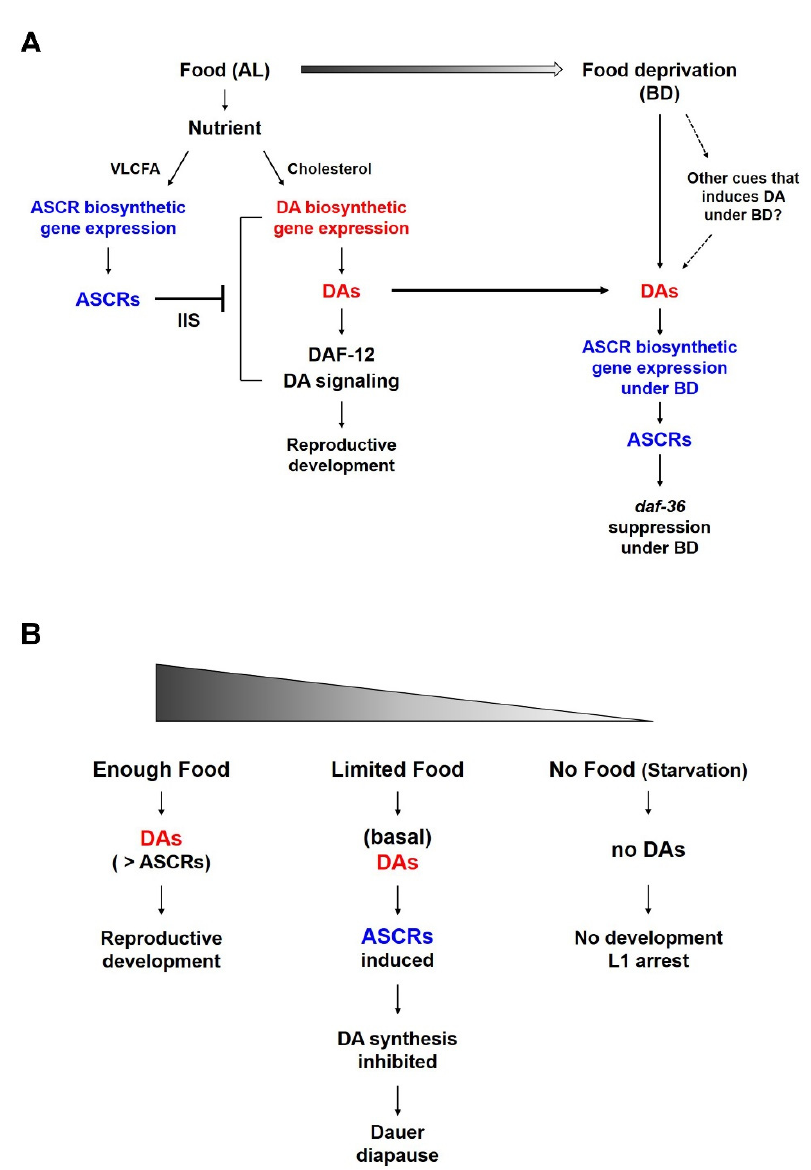
Figure 3. A working model of the reciprocal regulation between ASCR and DA and their e ff ects on C. elegans life history under di ff erent nutritional conditions. ( A ) Reciprocal regulation between ASCR and DA in L4 worms in response to food (AL) and under food deprivation conditions (BD). Di ff erent nutritional conditions influence ASCR and DA synthesis, eventually coordinating environmental cues (food availability) and animal development or survival. ( B ) Development of L1 / L2 worms in response to di ff erent nutritional conditions. In both ( A , B ), the color gradient represents the amount of food.